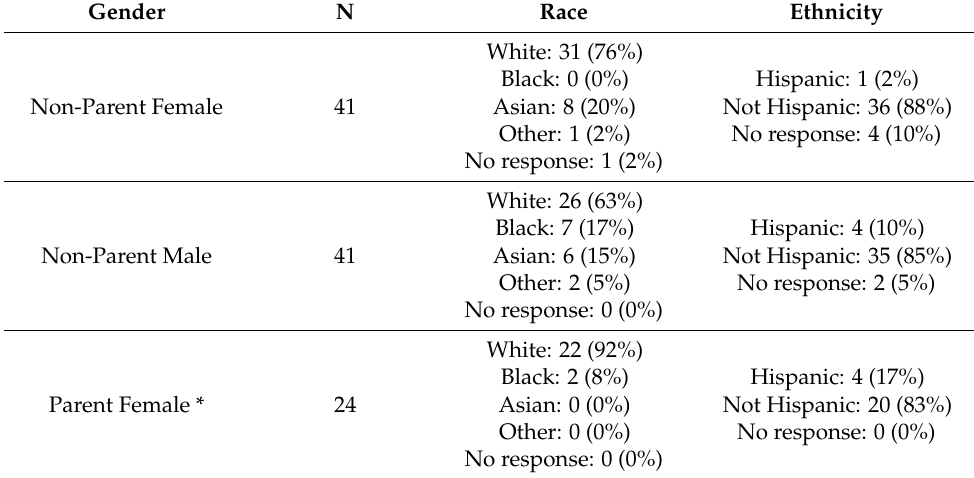
Table 1. Adult demographic